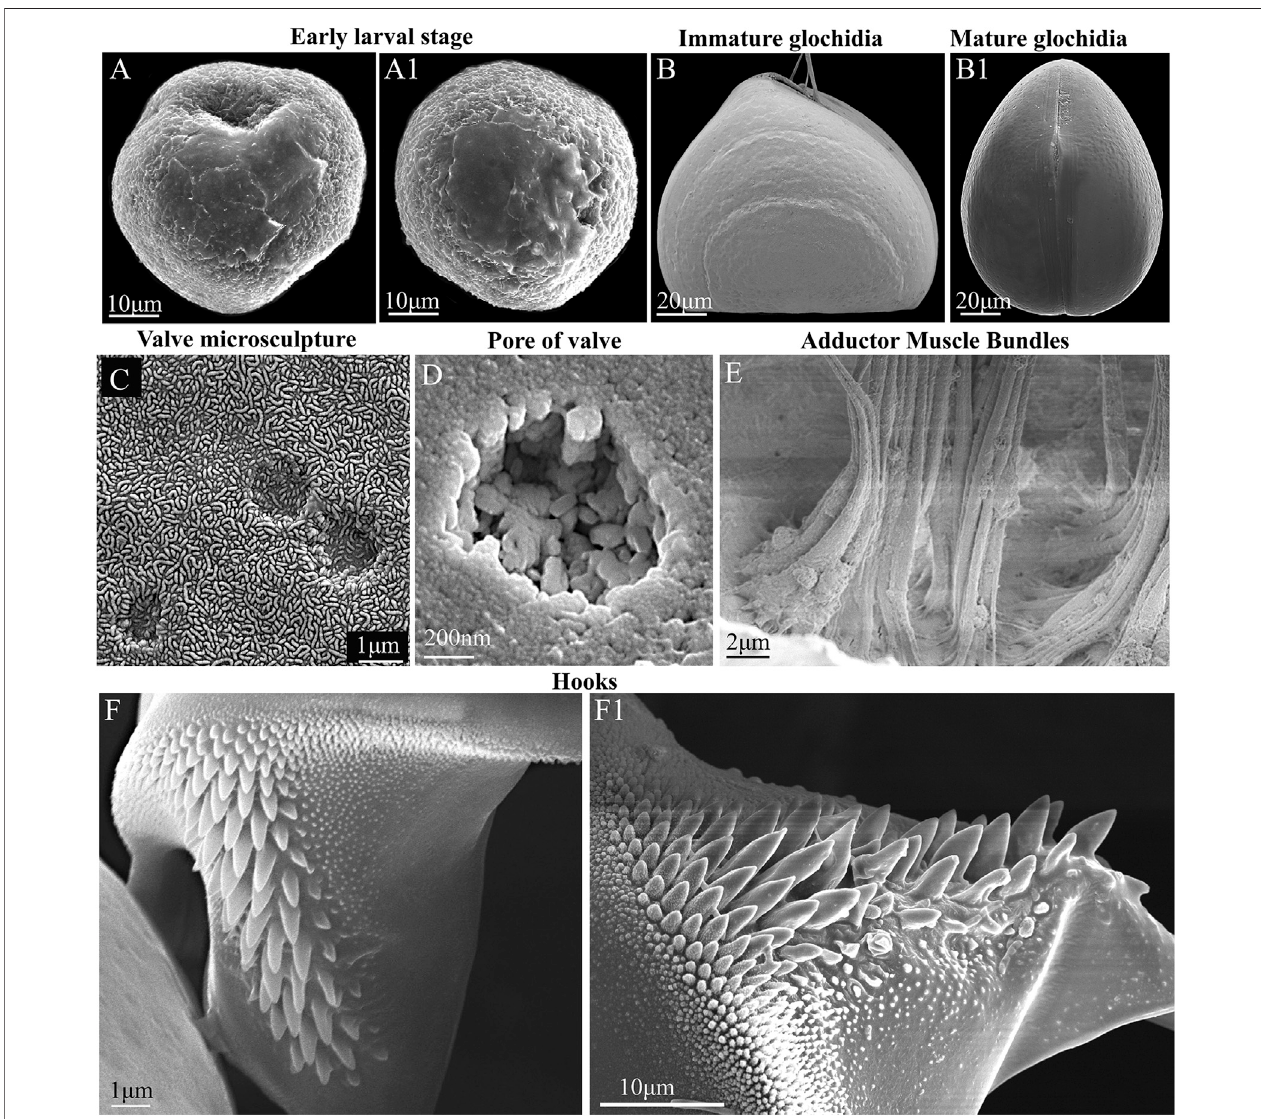
FIGURE 3 | Glochidia of Nodularia douglasiae: stages of development, external and internal morphology. (A,A1) Early larval stage. (B) Immature glochidium. The growth lines of the shell are visible; the immature larva does not yet have hooks (without potassium hydroxide treatment) at this stage of development. (B1) Mature glochidium, closed shell. (C) Exterior valve microsculpture at the center of the valve. This is the central part of the valve; three non-through pores are visible. (D) Pore on the inner surface ofthe valve. (E) Muscle bundles of thesmooth adductor. The photo wastaken through theslightlyopen valves gap; the edge ofthe shell is visible from below. (F,F1) Hook. SEM. Collection: Amur River basin. Scale bars, (A,A1,F1) , 10 μ m; (B,B1) , 20 μ m; (C,F) , 1 μ m; (D) , 200 nm; (E) , 2 μ m.